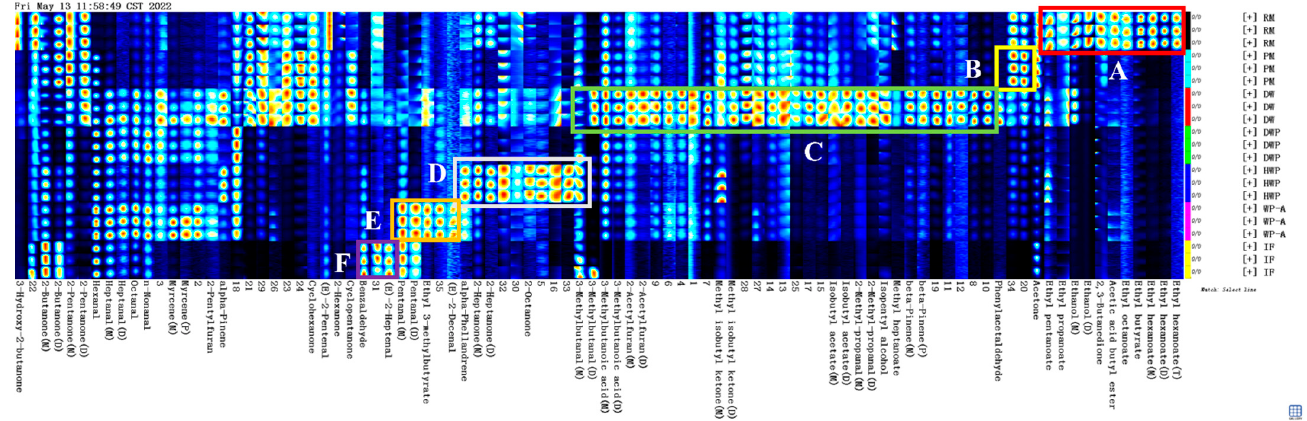
Figure 2. GC-IMS fingerprint spectra. A-E region represent the characteristics of sample RM, PM, DW, DWP, HWP; WPA and IF. RM, raw milk; PM, pasteurized milk; DW, demineralized whey; DWP, demineralized whey powder; HWP, hydrolyzed whey protein powder; WPA, whey protein powder with added alpha-lactalbumin; IF, infant formula.